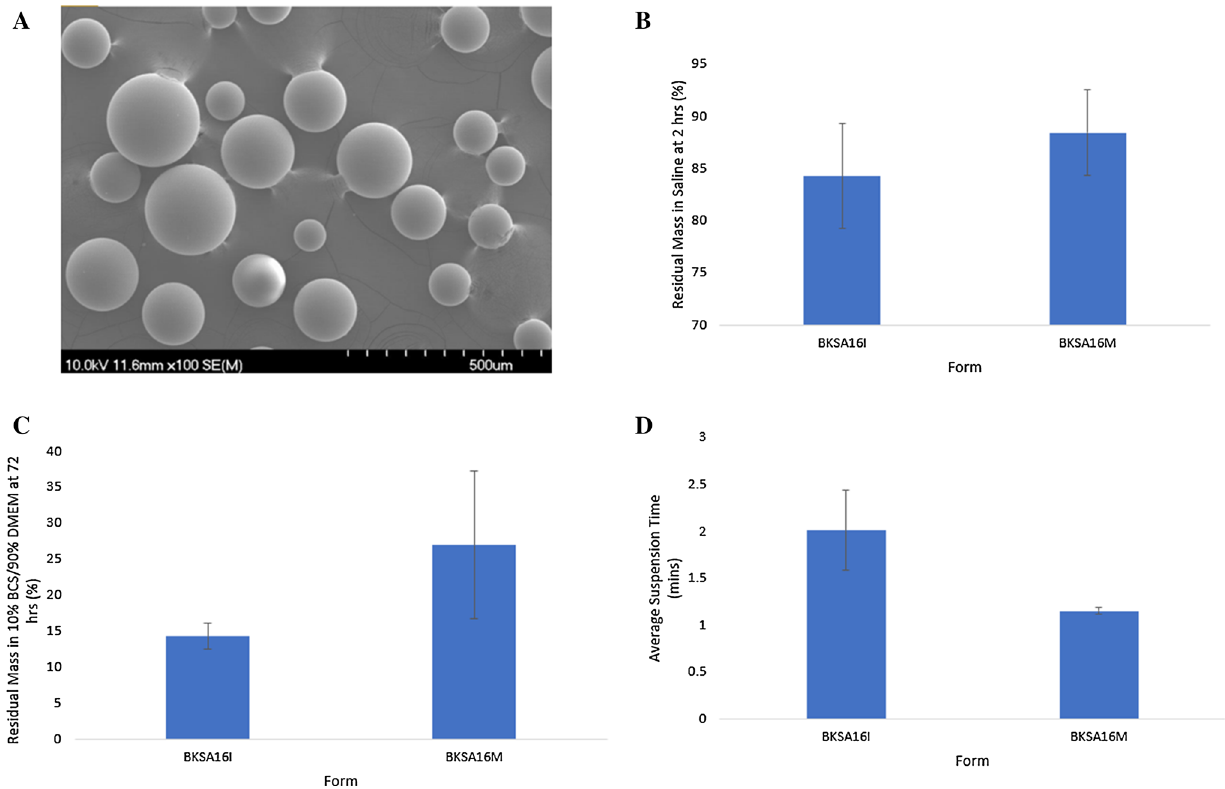
Fig. 2 A SEM image of BKSA16 microspheres (100x), B residual mass in saline at 2 h for BKSA16I and BKSA16M, C residual mass in 10% BSC/90% DMEM at 72 h for BKSA16I and BKSA16M, and D suspension times for BKSA16I and